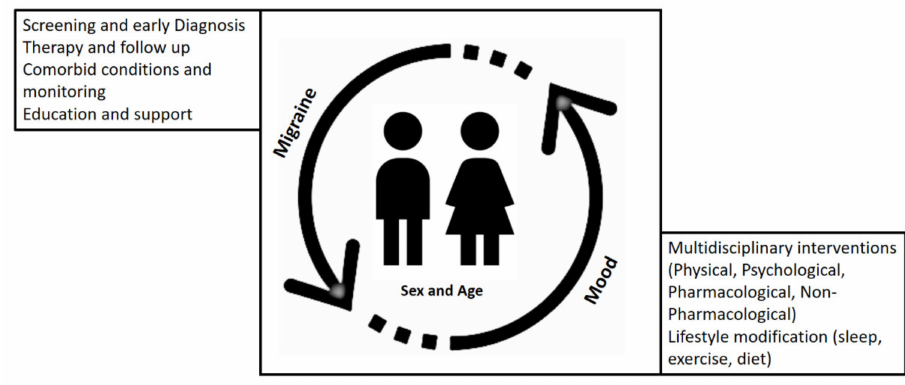
Figure 1. Mood and migraine relationship and points for treatment